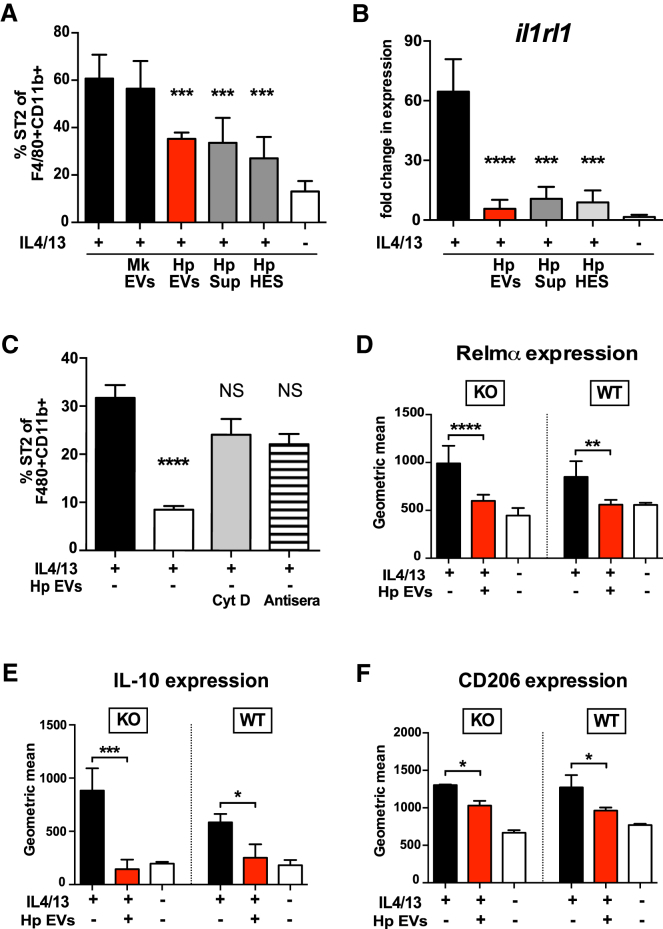
EVs Suppress ST2/IL-33R Expression in Macrophages during Type 2 Responses(A and B) The percentage of (A) ST2+F4/80+CD11b+ cells as determined by flow cytometry and transcriptional levels of (B) Il1rl1 as determined by qRT-PCR analysis in BMDMs cultured with IL-4/IL-13 ± 5 μg/mL EVs, EV-depleted HES (sup), or total HES (HES) for 24 hr. MODE-K EVs (Mk exo) are used as a control. Gating strategy is shown in Figure S3A.(C) The proportion of ST2-expressing BMDMs co-treated with 5 μg/mL EVs ± cytochalasin D or EV antisera, as determined by flow cytometry.(D–F) Representative expression of (D) intracellular RELMα, (E) IL-10, or (F) surface CD206 in wild-type BALB/c (WT) and T1/ST2−/− (KO) BMDMs treated with 20 ng/mL IL-4/IL-13 ± 5 μg/mL EVs, as assessed by flow cytometry. Data are pooled from two to three independent experiments and presented as mean values ± SD (n = 6–12; one-way ANOVA, ∗p < 0.05, ∗∗p < 0.01, ∗∗∗p < 0.001, and ∗∗∗∗p < 0.0001; NS, not significant).